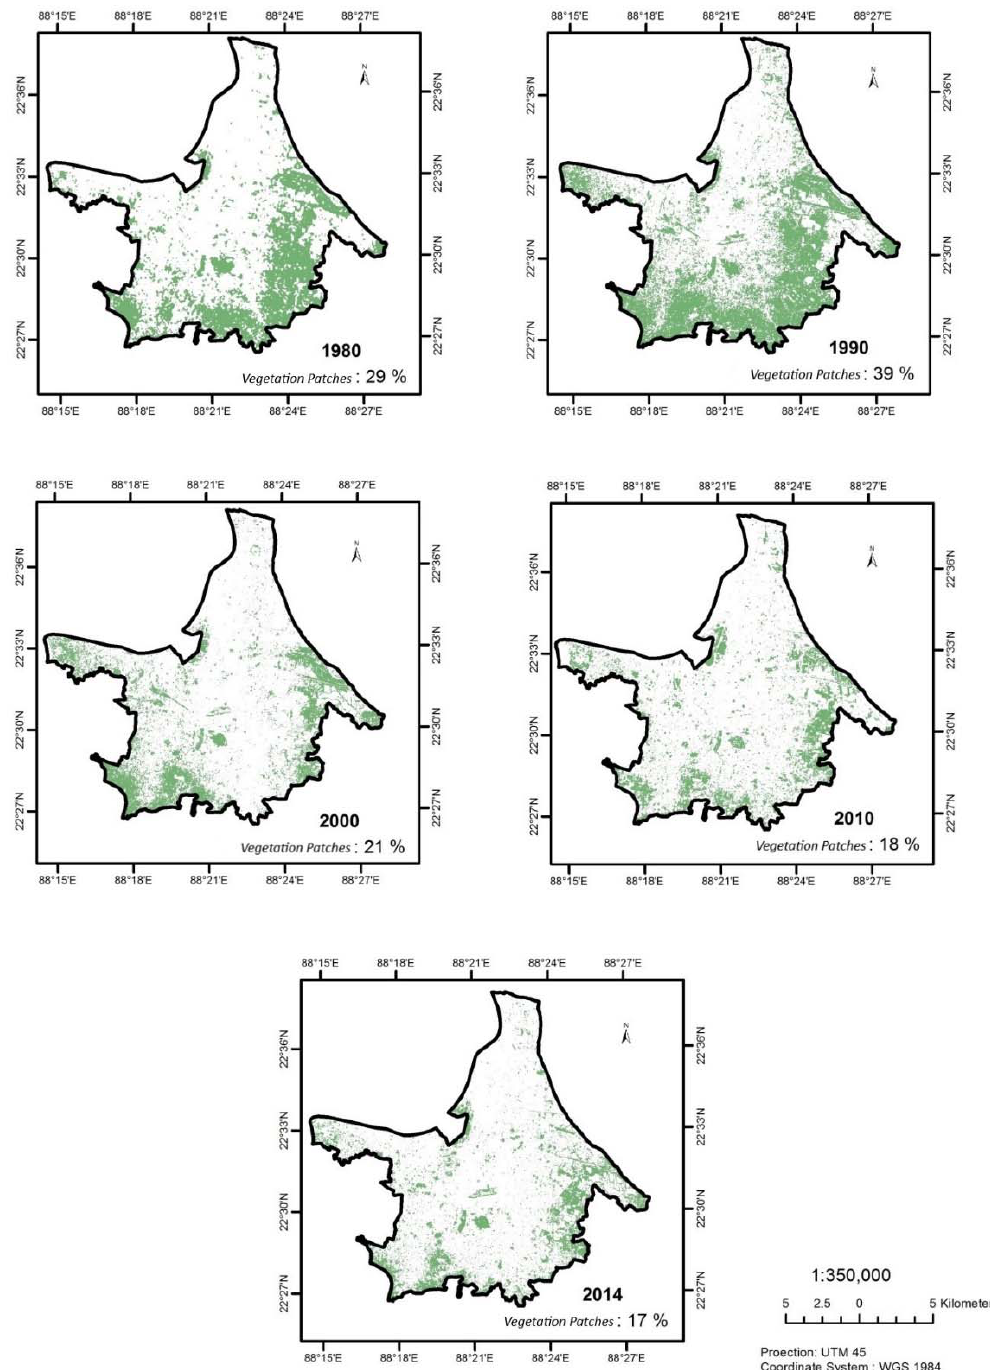
Figure 5. Distribution of vegetation patches (green patches) within Kolkata Municipal Corporation area (KMC) in time slices from 1980 to 2014 (decade-wise) (Data base courtesy: Satellite Image interpretation from Landsat (USGS) and LISS III series (ISRO, India) and the Govt. of West Bengal, India).